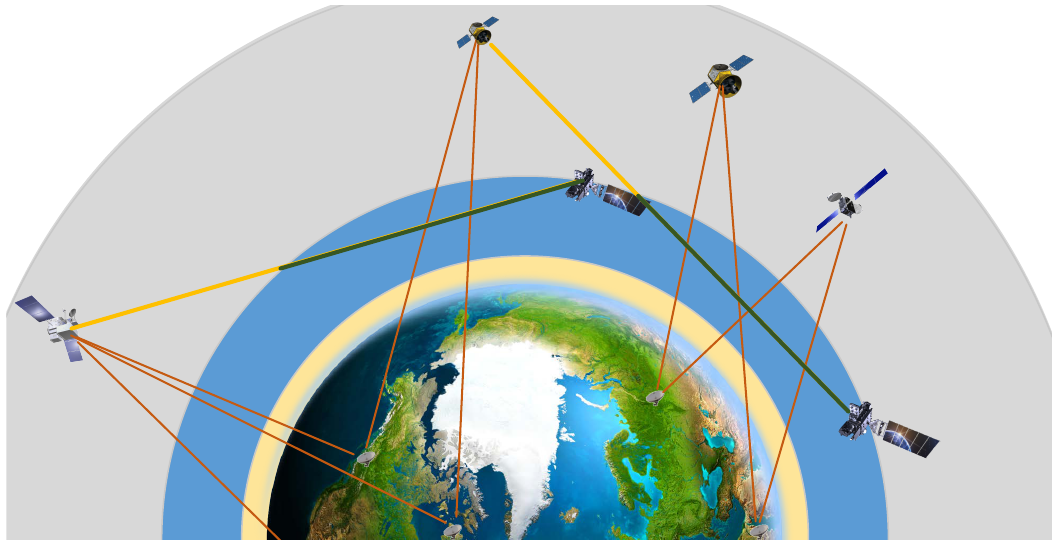
Figure 1. Multiobserving systems: green line, signal path across bottom region of the ionosphere 800 km during occultation; yellow line, signal path across the top region during occultation; and orange line, signal path across the ionosphere of ground-based GNSS